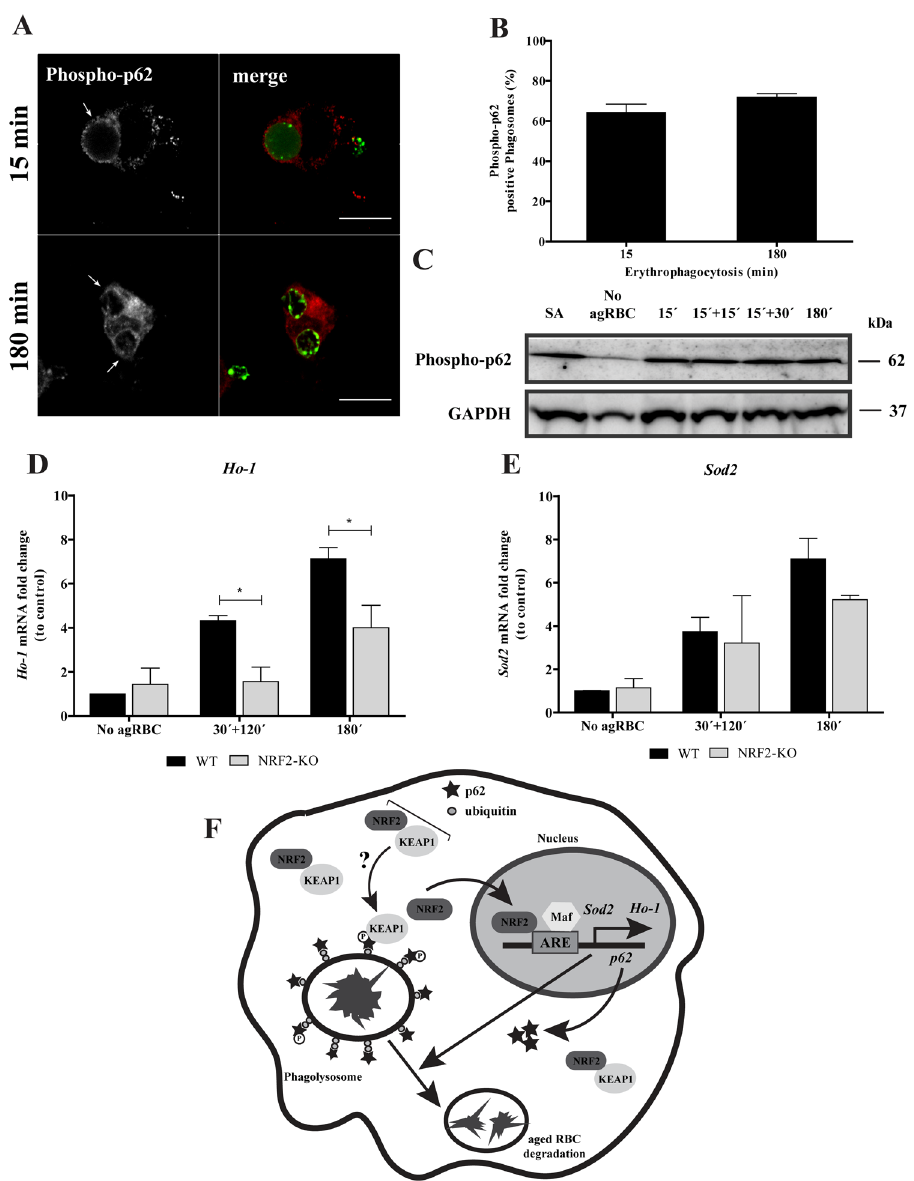
Figure 8. p62 Phosphorylation and NRF2-target genes expression upon erythrophagocytosis. WT-BMDM were fed and chased with CFSE-labeled RBC for the times indicated and imunostained for phospho-p62 ( A , B ) Quantification of phosphorylated p62-positive phagosomes. The values are means ± SEM expression levels of 2 independent experiments. ( C ) phosphorylated-p62 levels in cell lysates exposed to RBC. GAPDH was used as loading control. Two independent experiments were performed. As positive control, Sodium arsenite was added for 12 h to a final concentration of 10 µ M. In D-E, WT- and NRF2-KO-BMDM were challenged with RBC for 30 min and then chased for 120 min or fed for 180 min. The expression of HO-1 ( D ), SOD2 ( E ) genes was assessed by RT-qPCR. Data were normalized to the endogenous Hprt and Pgk1 genes. The values are means ± SEM expression levels of three independent experiments, each measured in two technical replicates. * p < 0.05. ( F ) Working Model: Our model suggests that degradation of RBC by macrophages is dependent on p62/NRF2 signaling pathway. p62 is recruited to RBC-containing phagosomes decorated with ubiquitin shortly after erythrophagocytosis, followed by phosphorylation in the S351 residue and KEAP1 acquisition, by an unknown mechanism. Then, after phagolysosome formation NRF2 is translocated to the nucleus where together with small Maf proteins, binds to ARE in promoter region of Ho-1 , p62 and Sod2 genes, inducing their expression. This molecular machinery promotes aged RBC degradation and controls oxidative stress. NRF2 - nuclear factor erythroid derived 2-like 2; KEAP1 - Kelch-like ECH-associated protein 1; ARE – antioxidant response element; Maf - small masculoaponeurotic fibrosarcoma; Sod2 - superoxide dismutase 2; Ho-1 - hemoxigenase